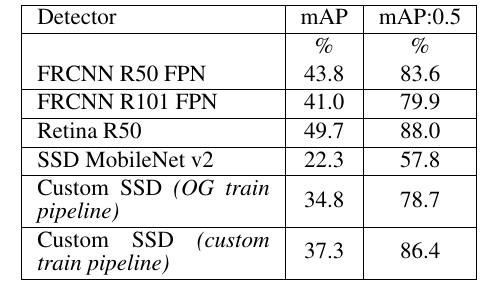
Table 4. Inference performance on an Nvidia RTX 3090 based